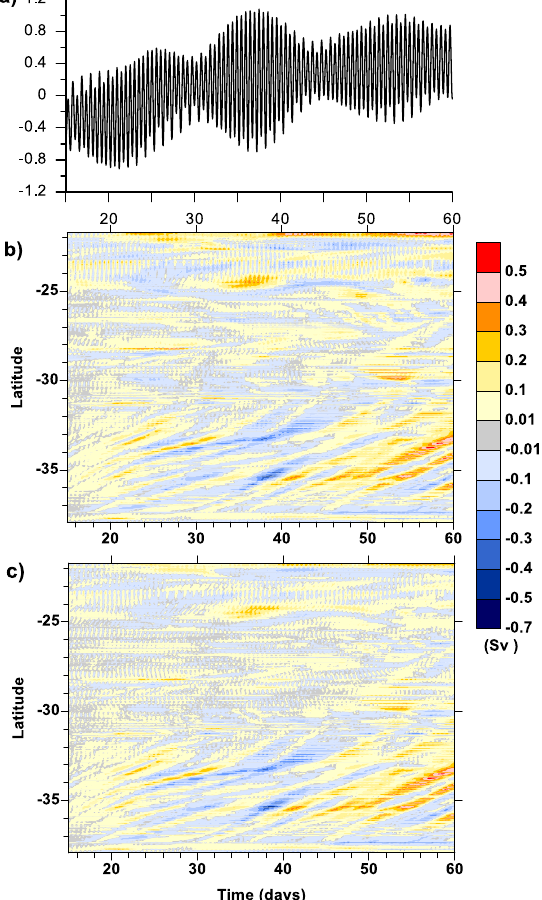
the daily and spring-neap tidal cycles. b Difference in flow normal to the continental shelf/slope break at 200 m between the tidal and non-tidal simulations. c Same as b for water colder than 18 °C. Negative values indicate either an increase in a westward flow or a decrease in an eastward